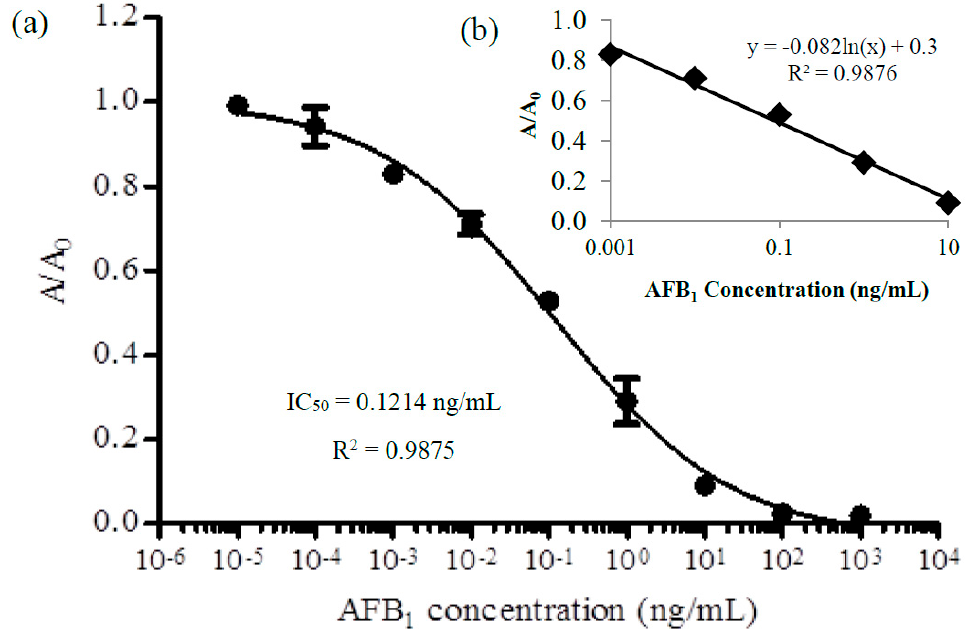
Figure 4. ( a ) Calibration curve of AFB 1 for indirect ELISA format using spectrophotometric detection (Error bar = standard deviation, n = 3); and ( b ) linear regression of standard curve with AFB 1 working range from 0.001 to 10 ng/mL.